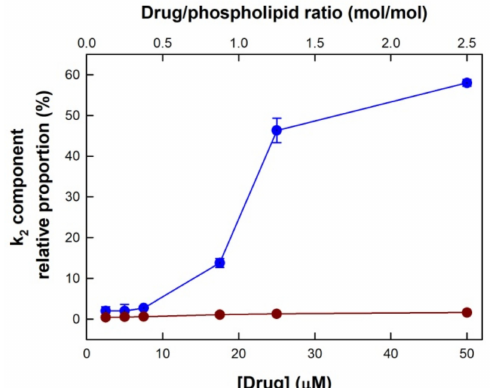
Figure 3. The relative proportion of the k 2 rate constant component for the druginduced CF leakage from POPC LUV, as a function of TMX (blue) or HTMX (red) concentration. Top axis shows the drug/phospholipid molar ratio. S.E. bars are shown when bigger than the